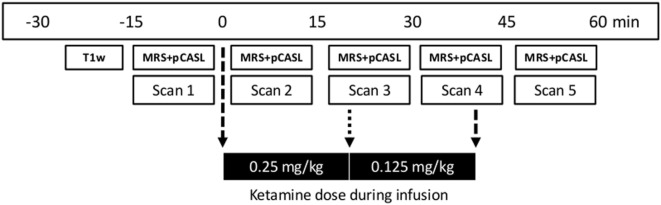
Time line of magnetic resonance imaging acquisitions and dose regimen of S-ketamine infusion. First, a T1-weighted structural scan (T1w; duration 10 min) was acquired followed by five sets of 1H-MRS and pCASL data (total acquisition time 11 min) before (scan 1), during (scans 2–4), and after (scan 5) S-ketamine infusion. Stippled arrows indicate the start and end of infusion and the dotted arrow dose change. MRS, Magnetic resonance spectroscopy; pCASL, pseudo-Continuous Arterial Spin Labelling.